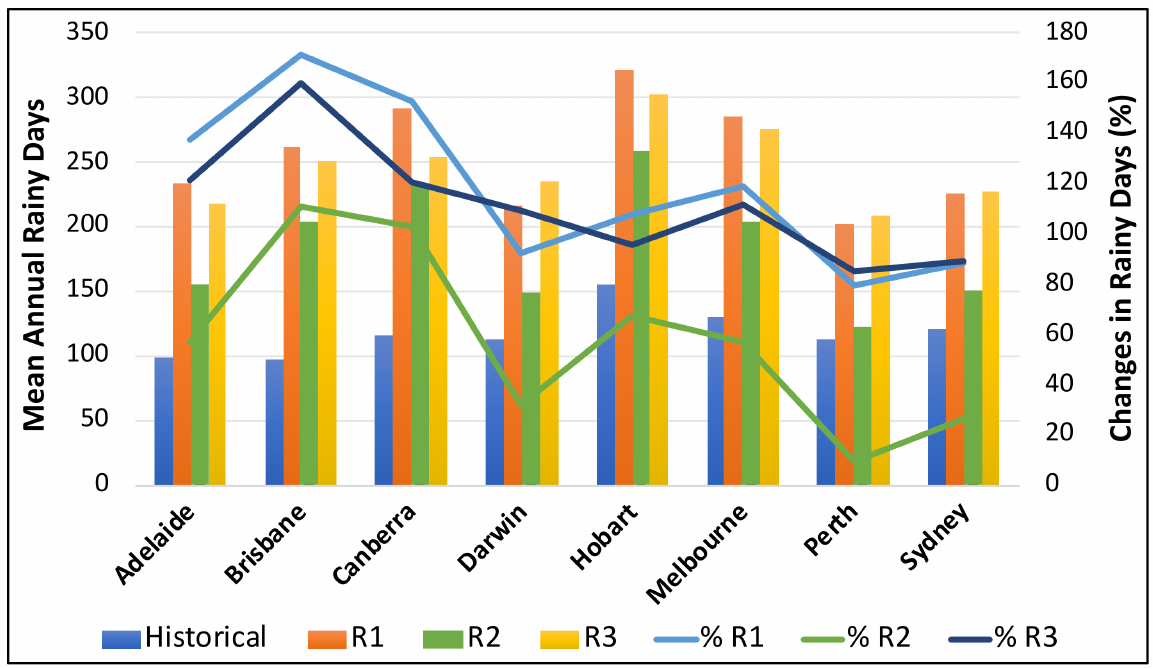
Figure 4. Average annual number of rainy days and percentage changes between the future period (2022–2039) and historical